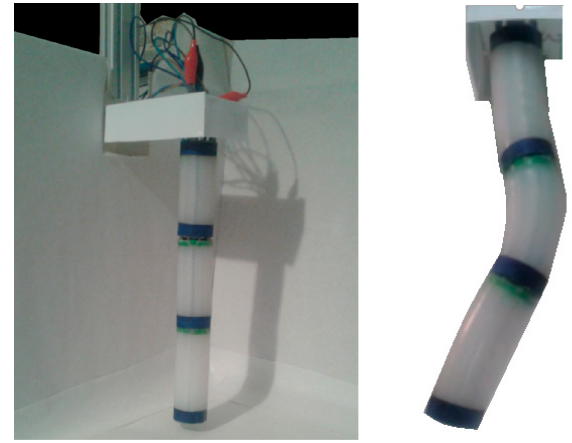
Figure 7. The final prototype. Source: authors.